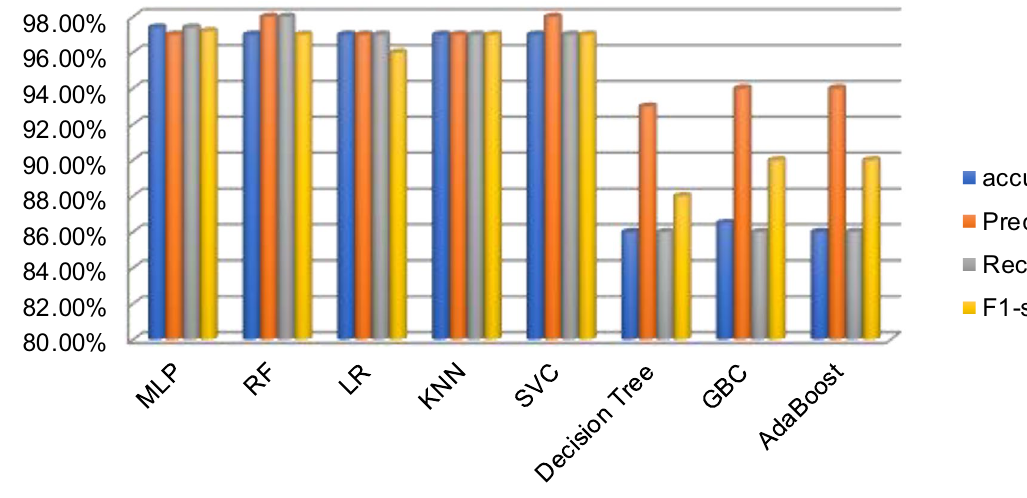
Fig. 4 Highest performance comparison of different classification algorithms on top 10